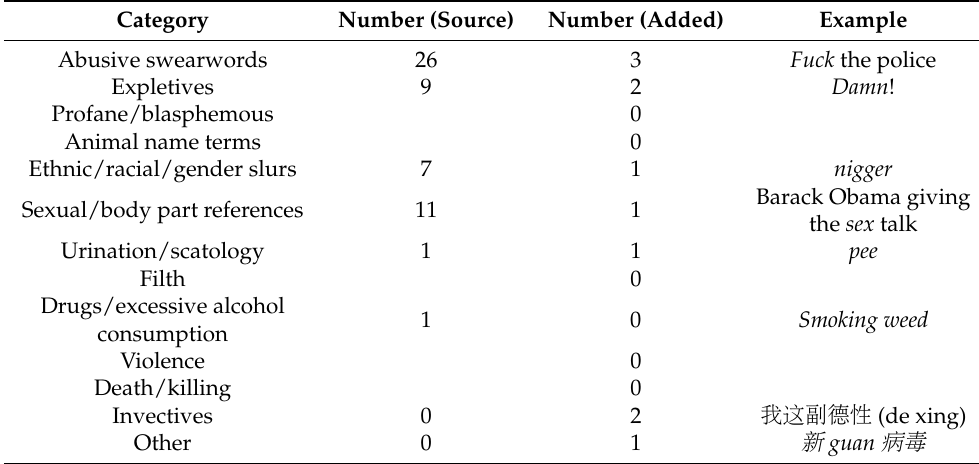
Table 2. Categories, numbers, and examples of taboo language.